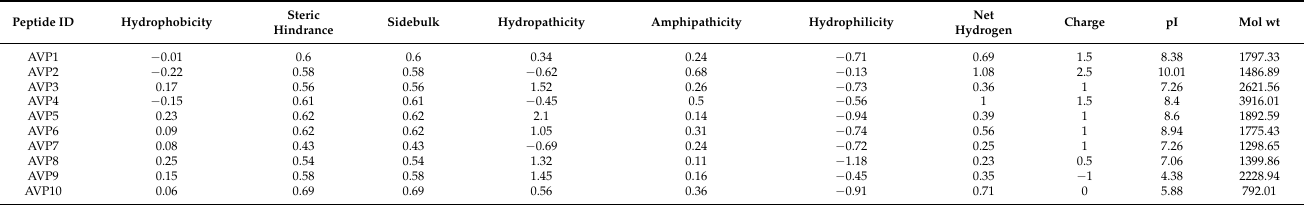
Table 2. Calculated physicochemical property scores of the selected AVP candidates (AVP1 to AVP10) by ToxinPred.